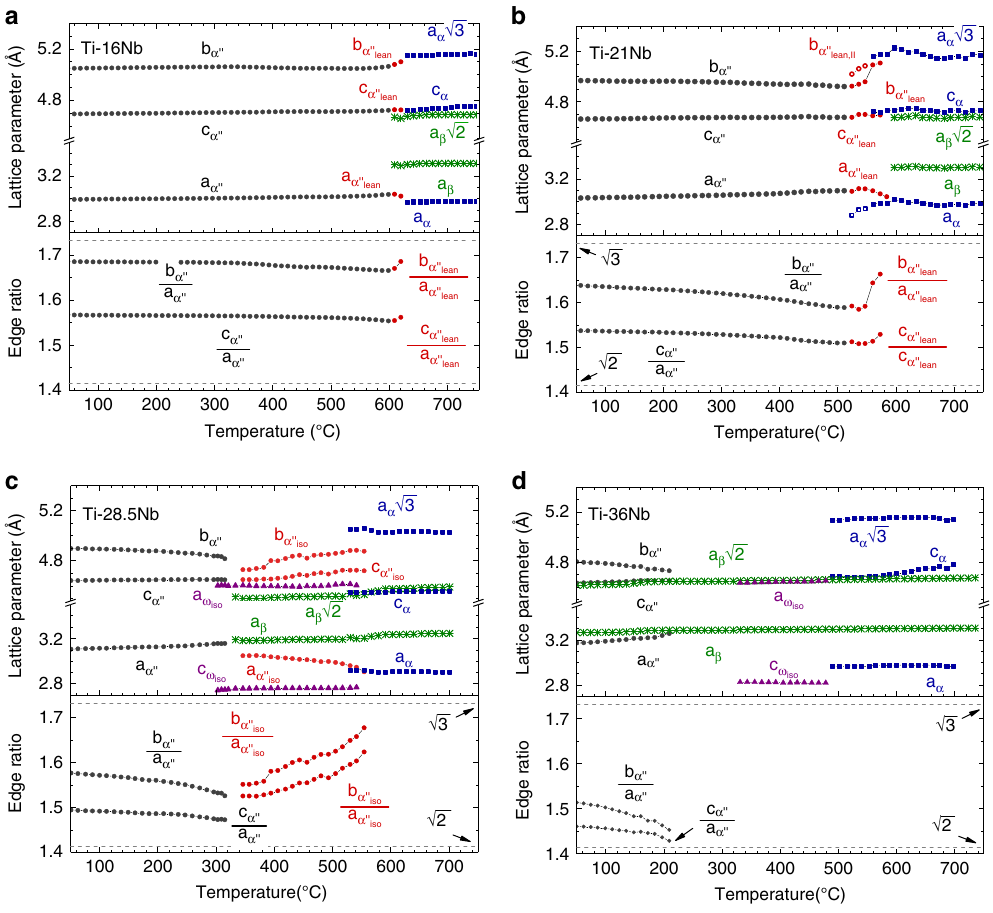
Fig. 3 Heating-induced variation of unit cell geometries. Structural evolution during heating at 10 °C min − 1 for a Ti – 16Nb b Ti – 21Nb c Ti – 28.5Nb and d Ti – 36Nb. For each composition the upper panel shows the re fi ned lattice parameters of all phases detected and the lower panel the ratios of b and c relative to a for the orthorhombic phases. The re fi nement uncertainty is smaller than the